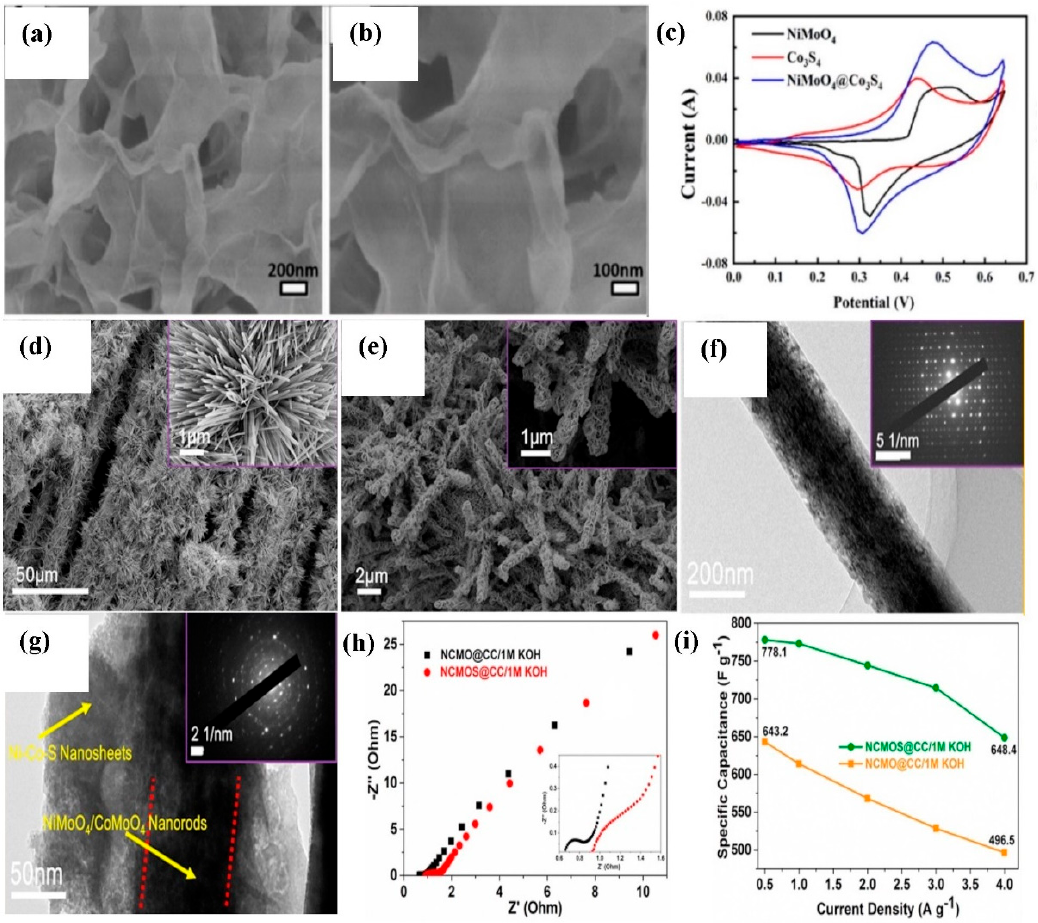
Figure 6. ( a , b ) SEM images of NiMoO 4 − Co 3 S 4 nanosheets on NF, ( c ) CV curves of NiMoO 4 (12 h), Co 3 S 4 and NiMoO 4 − Co 3 S 4 electrodes at 10 mVs − 1 scan rate [121]. Reproduced from Ref. [121] with permission from Elsevier, 2022. ( d , e ) SEM images, ( f , g ) TEM images (inset: SAED patterns), ( h ) Nyquist plots for NCMO/CC and NCMOS/CC, ( i ) Variation of mass − specific capacitance over current density for NCMO/CC and NCMOS/CC [123]. Reproduced from Ref. [123] with permission from Elsevier, 2019.